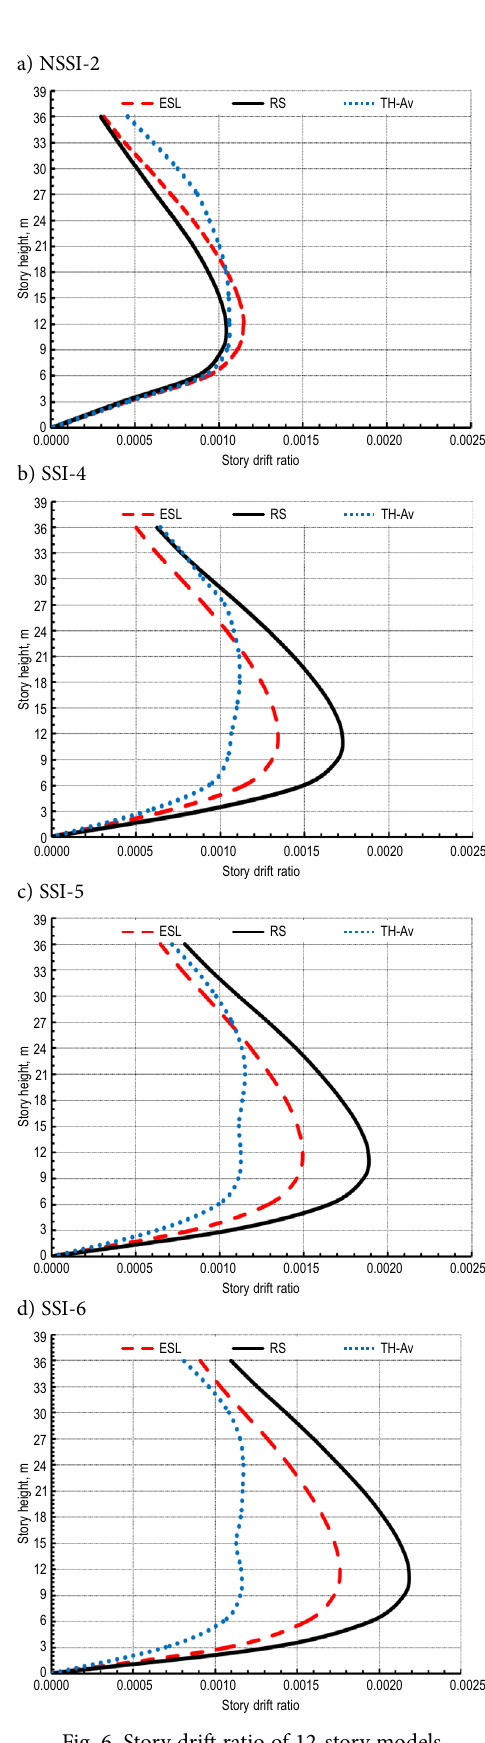
Fig. 6. Story drift ratio of 12-story